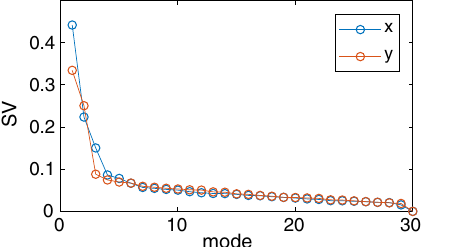
FIG. 6. Singular values of 30 trajectories over 126 BPMs.